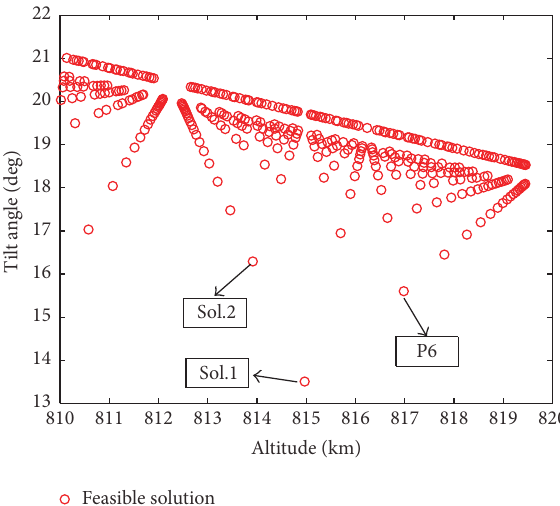
Figure 8: Feasible orbit solutions within RT des = 5 when repeat cycle 𝐷 max = 200 .